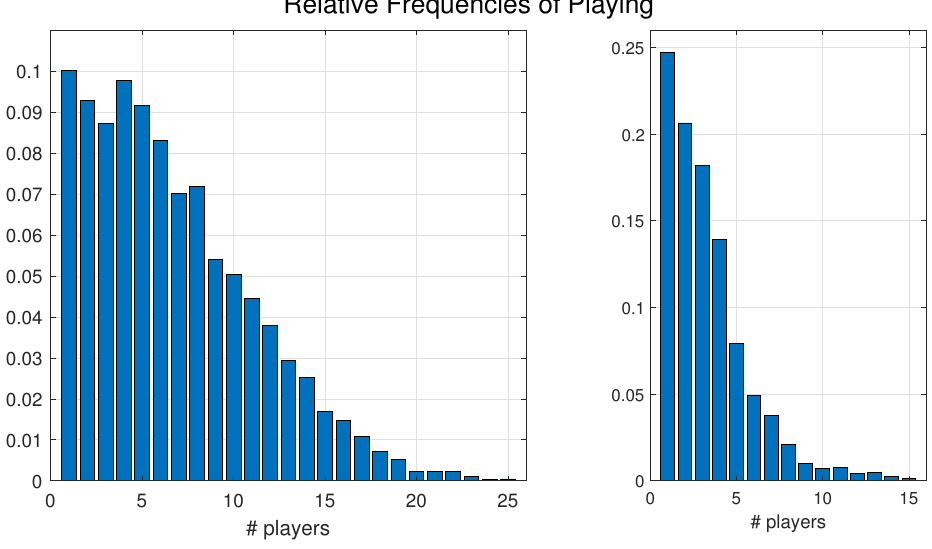
Figure 6. Distribution of simultaneous play.